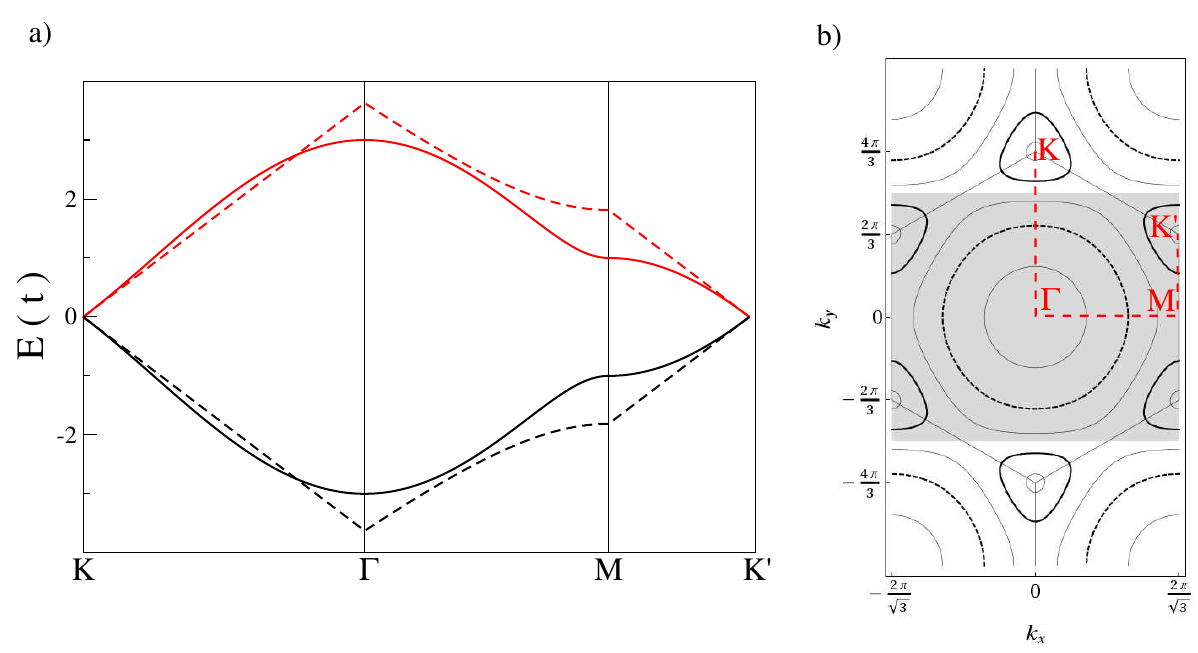
Figure 3. ( a ) shows the band structure of graphene calculated using both the tight-binding Hamiltonian (solid lines) and the linearised Hamiltonian (dashed lines). The bands are plotted along the high symmetry points of the graphene Brillouin Zone shown by the dashed red plot in ( b ). The shaded rectangular area in ( b ) is a possible alternative to the standard hexagonal Brillouin